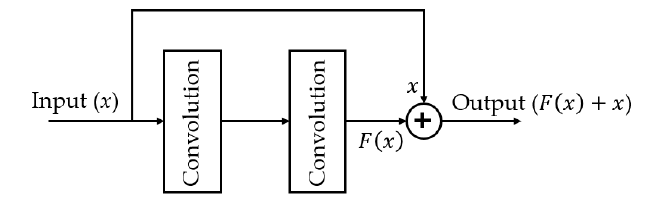
Figure 6. Methodology for constructing the residual convolution